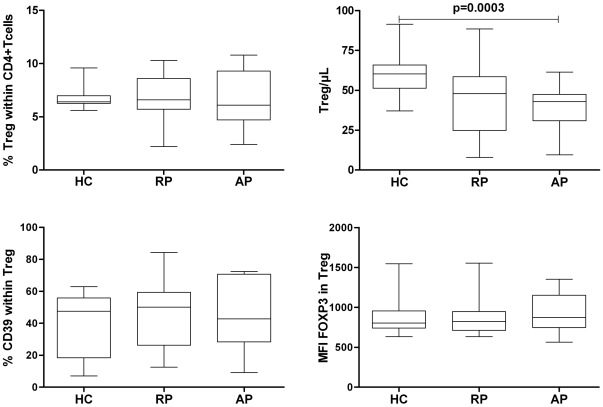
Frequency, number and phenotype of Treg in patients vs. controls.Histograms represent: A, Proportion of CD4+CD25highCD127low/− T cells within CD4+CD3+ T cells (as gated in figure 2A) for HC (mean, 6.8%, n = 18), remission, (mean, 6.9%, n = 15), and acute (mean, 6.7%, n = 19) AAV patients. No significant difference was observed for percentage of Treg cells between the 3 groups. B, Absolute numbers of CD4+CD25highCD127low/− T cells in whole blood for HC (mean, 60.3 cells/µL), remission (mean, 47.5 cells/µL), and acute (mean, 40.1cells/µL) AAV patients. C, MFI of FOX-P3 in gated Treg and D, Mean percentage of CD39+ cells within Treg. Data are presented as boxplots with whiskers from minimum to maximum.